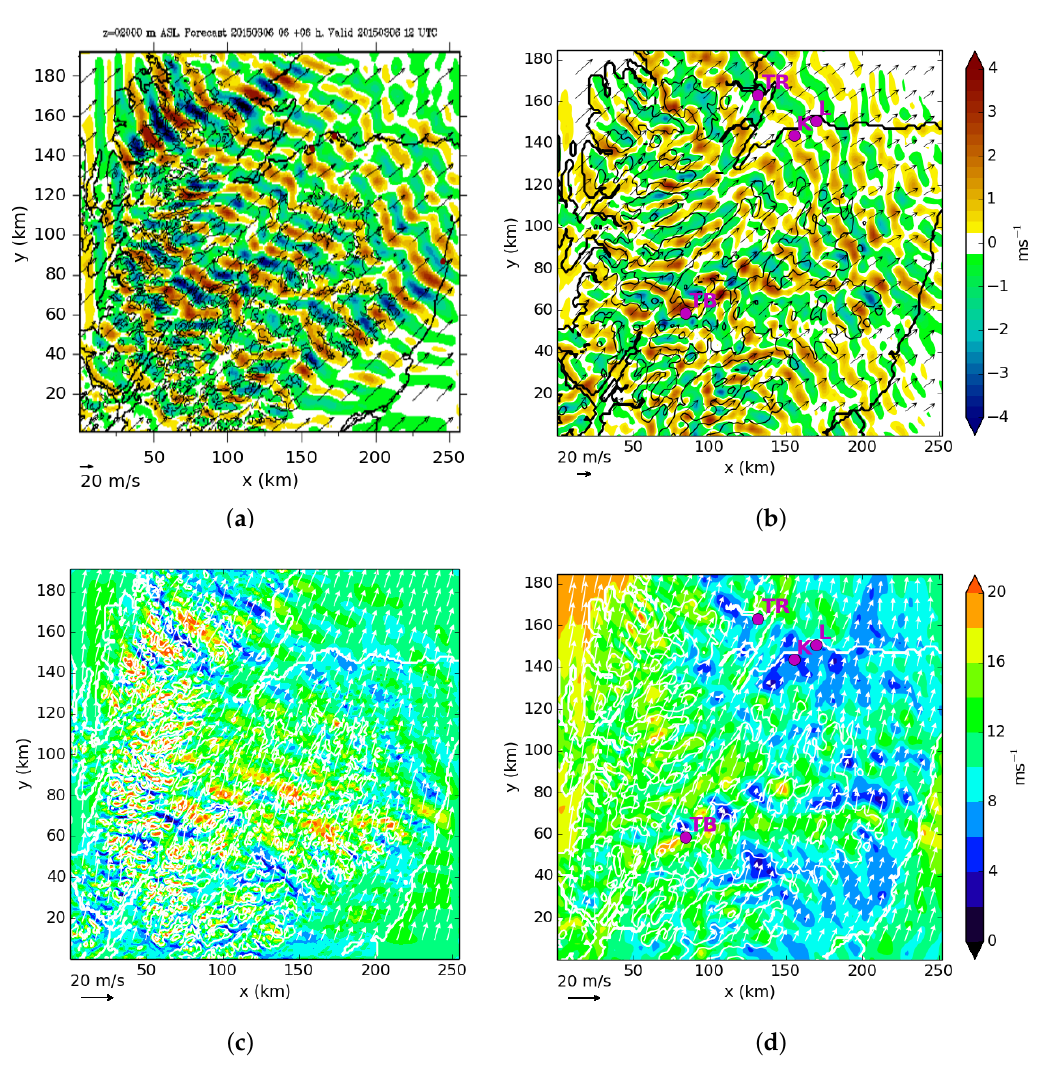
Figure 8. w at 2000 m ASL from ( a ) the operational 3DVOM run; ( b ) UKV with ENDGame core; and 10-m wind from ( c ) 3DVOM and ( d ) UKV with ENDGame core, valid at 12 UTC 6 March 2015. Locations of surface observing sites “Tain Range’ (TR), “Tulloch Bridge’ (TB), “Kinloss’ (K) and “Lossiemouth’ (L) are marked in (b,